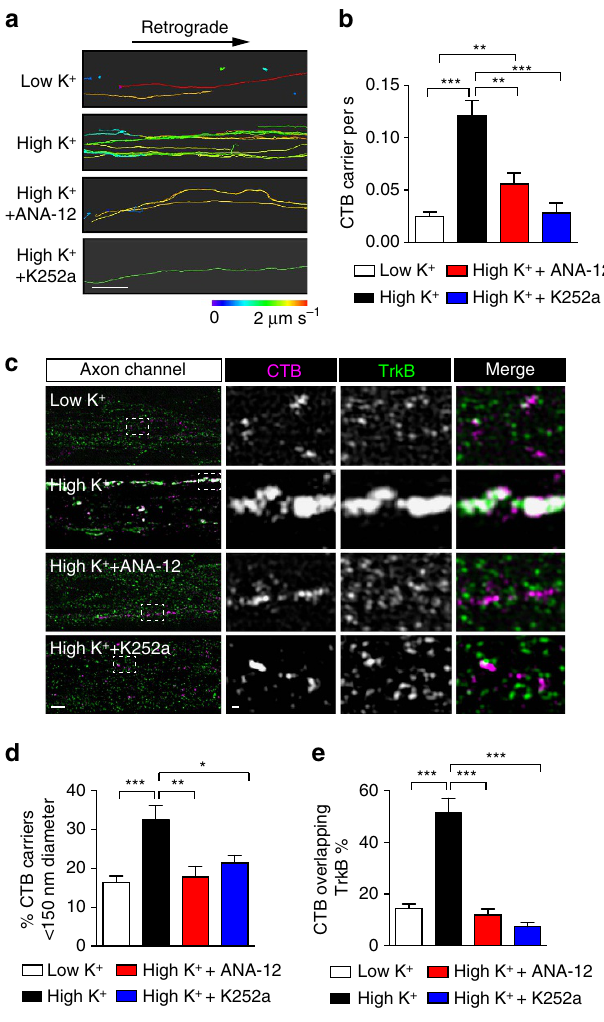
Figure 6 | Pharmacological inhibition of TrkB activation abolishes the activity-dependent increase in CTB carrier flux undergoing retrograde axonal transport. ( a ) Representative images of CTB retrograde flux inside the axon channels of hippocampal neurons pretreated with 0.5 m M ANA-12 or 100nM K252a for 30min before high K þ pulse-chase. Neurons pulse-chased with low or high K þ alone were used as controls. Time-lapse images were tracked with Imaris software, and the tracks shown are colour-coded based on the average speed. Scale bar, 10 m m. Both inhibitors significantly abolished thehigh K þ stimulation-induced CTB flux, as reflected by the decreased number of CTB carriers trafficking through the axon channels per second as quantified in b , (mean ± s.e.m., n ¼ 78 (low K þ ), 81 (high K þ ), 83 (high K þ þ ANA-12) and 45 (high K þ þ K252a) tracks, data from 3 independent neuron preparations, * P o 0.05, ** P o 0.01,*** P o 0.001, Student’s t -test). ( c ) Representative SIM images of axons in microfluidic chambers. Neurons were labelled with CTB (red) under either low K þ or high K þ conditions. In the bottom groups, neurons were pretreated with ANA-12 or K252a for 30min before high K þ stimulation. TrkB antibody (green) was used to label endogenous TrkB receptors, Scale bar, 2 m m. Boxed regions are magnified in the right panels, Scale bar, 200nm. ( d , e ) Both inhibitors significantly reduced the number of small CTB carriers with a diameter o 150nm ( d ), as well as the ratio of CTB overlapping with TrkB as quantified in ( e ). (Mander’s coefficient, mean ± s.e.m., n ¼ 39 (low K þ ), 46 (high K þ ), 32 (high K þ þ ANA-12) and 25 (high K þ þ K252a) tracks, data from three independent neuron preparations, * P o 0.05, ** P o 0.01,*** P o 0.001, Student’s t -test).